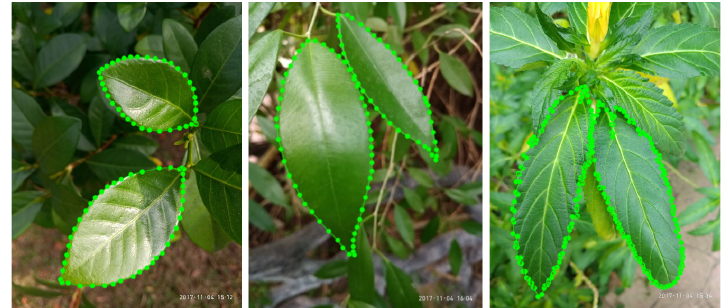
Figure 2. The images during the labeling process.